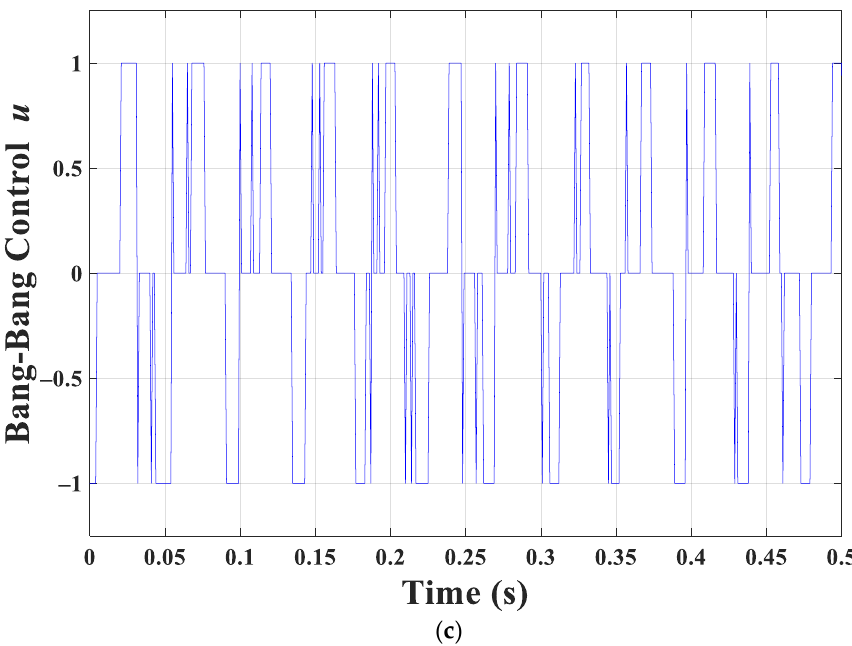
Figure 3. ( a ) Output membership function, ( b ) bang-bang firing action of I1 and I2, and ( c ) bang-bang output of FBBRC.